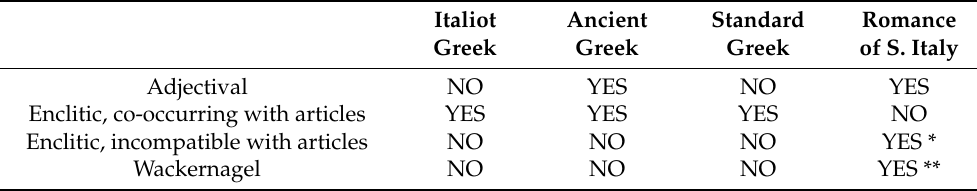
Table 6 sums up the distribution of possessives in Italiot Greek, Ancient Greek, stan- dard Greek and Romance of Southern Italy: Italiot Greek does not have any of the posses- sives found in the neighboring Romance dialects. Table 6.